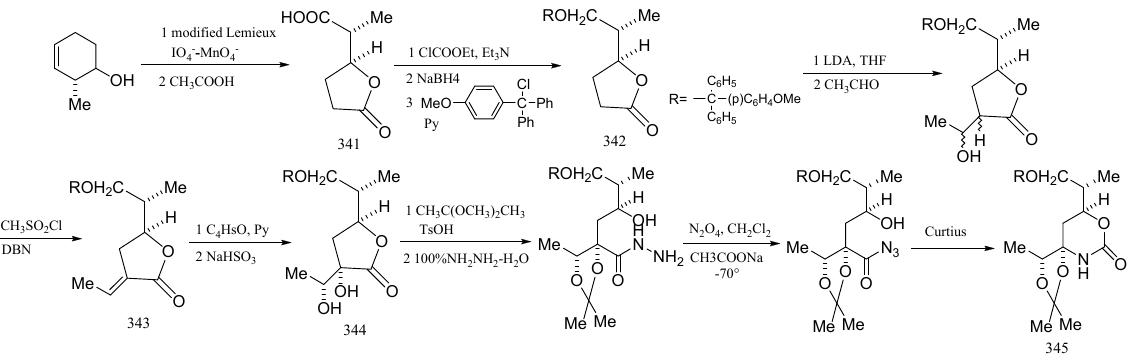
Figure 18. Compounds synthesized from the cyclic carbamate unit of maytansine.